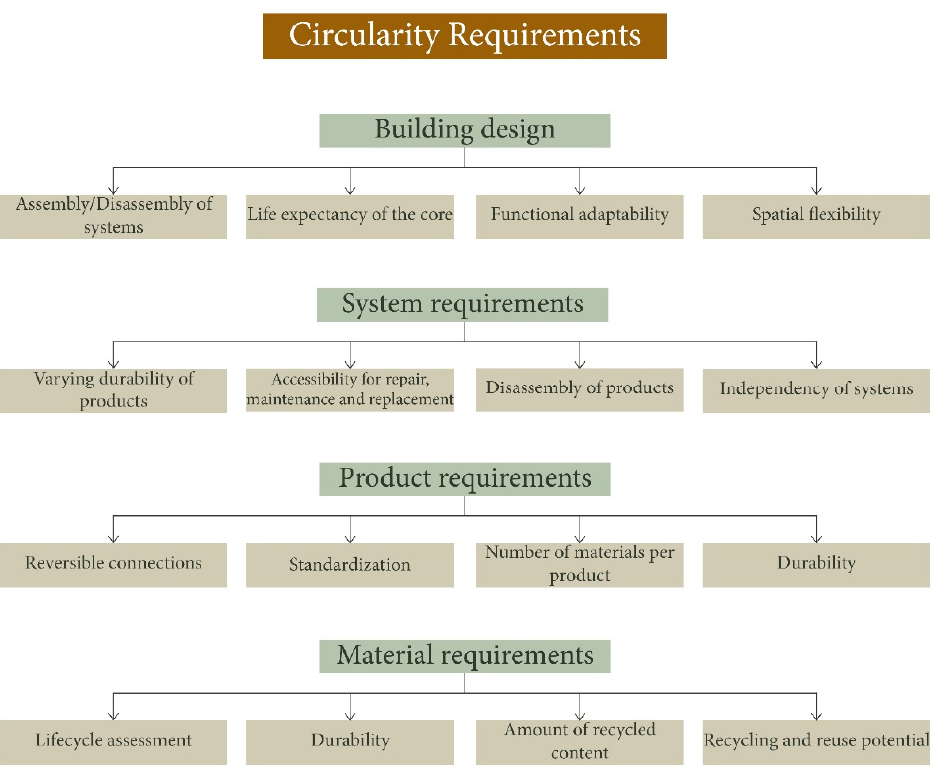
Figure 2. Circularity requirements.